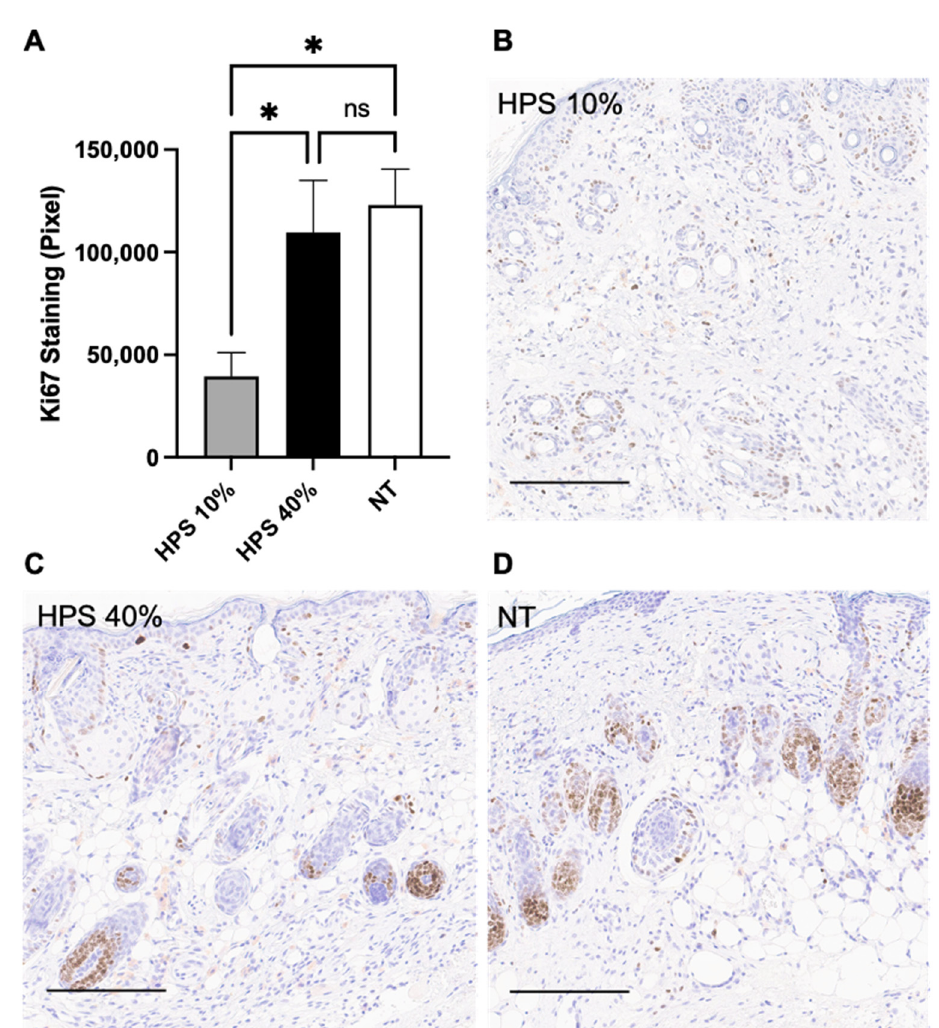
Figure 4. Ki67 DAB Immunostaining. ( A ) Quantitative measurement of Ki67 Diaminobenzidine (DAB) staining in HPS-10% ( n = 14) and 40% ( n = 14) treated murine wounds vs. no treatment (NT) ( n = 10) on POD 15 by color segmentation of DAB-positive cells calculated as pixels. HPS-10% group showed the least Ki67 expression compared to HPS-40% ( p = 0.03) and NT group ( p = 0.02). Data are means ± SEM. * = p < 0.05, ns = non-significant. One-way ANOVA with Tukey’s post-hoc test. ( B – D ) Representative high-power fields of Ki67 DAB Immunostaining of HPS-10%, HPS-40% treated wounds and NT wounds. Ki67 positive cells were mainly located on POD 15 in the dermal papillary cells as well as in the basal and suprabasal epithelial layers. Scale bar = 200 µm.